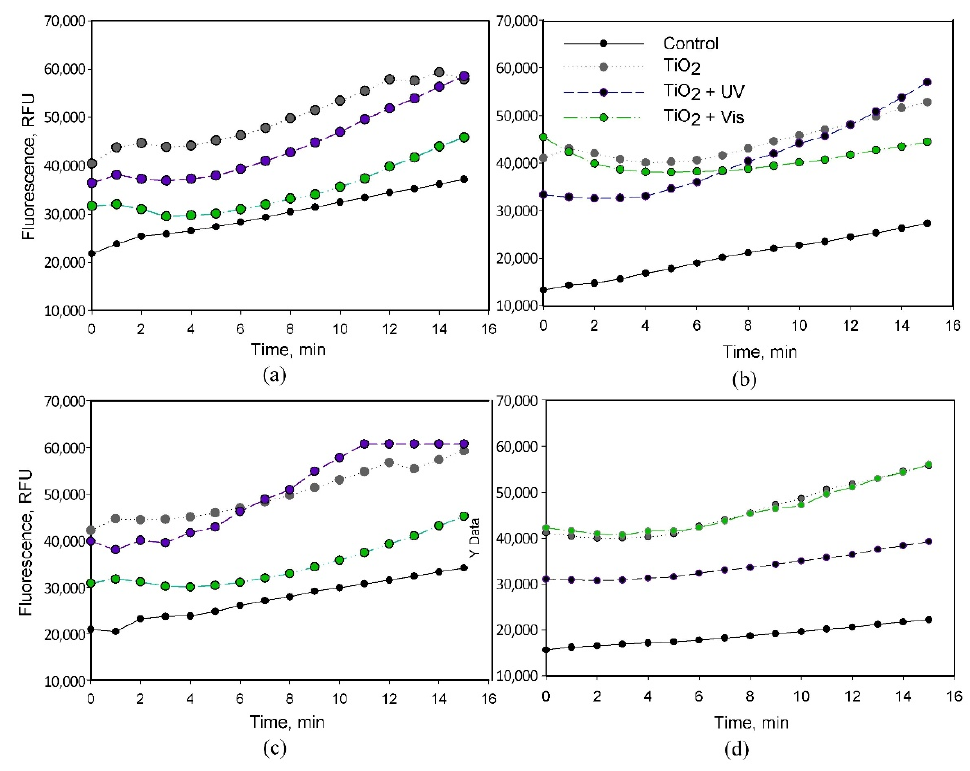
Figure 5. Intracellular ROS generation in S. Typhimurium cells. The experiments were performed at: ( a , b ) 22 °C or ( c , d ) 37 °C; ( a , c ) in absence of glucose or ( b , d ) in the medium containing 0.1% glucose. One hundred μ L of concentrated cell suspension (OD 600 of 0.1) contained 10 μ M DCFH-DA. The excitation wave was λ ex = 492 nm, and emission λ em = 535 nm.